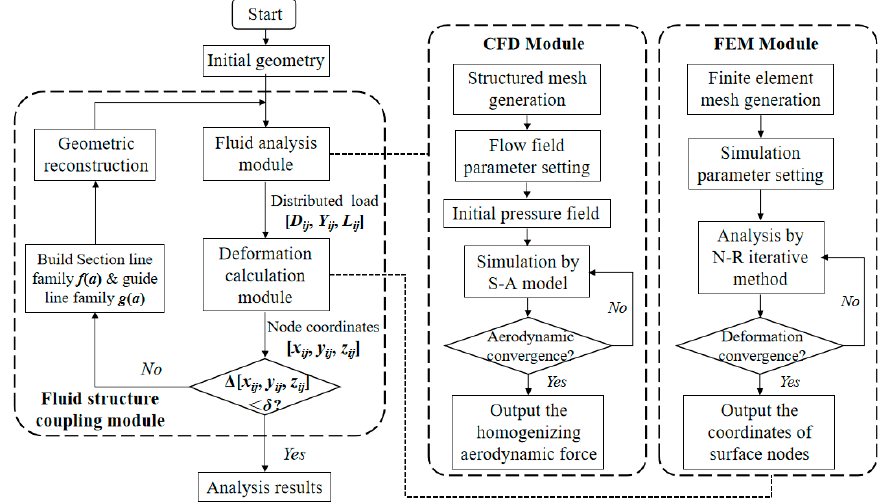
Figure 15. Fluid-structure coupling analysis framework.